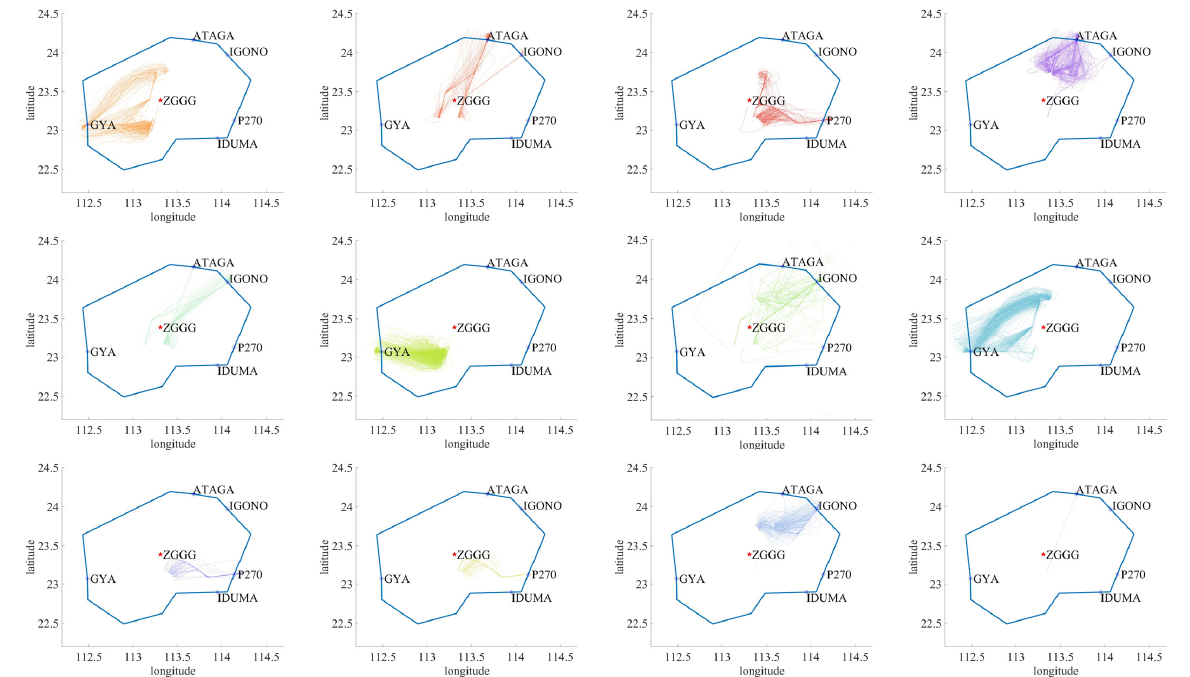
Figure 10. Clustering results of flight trajectories of ZGGG (K-Means).